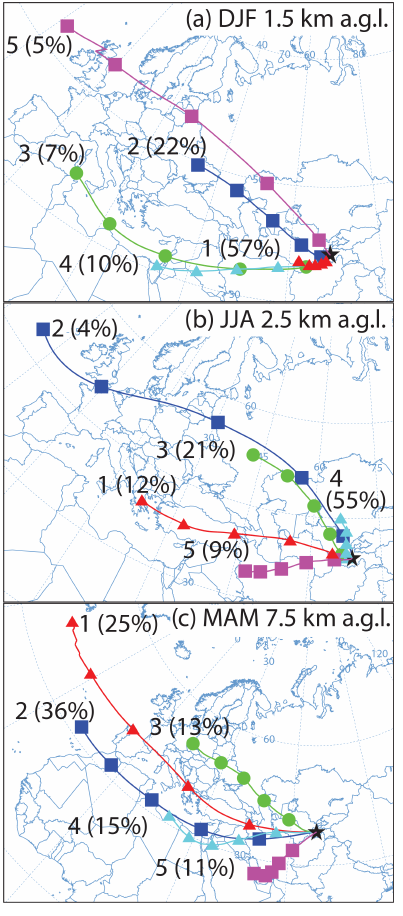
Figure 5. Results of the seasonally resolved HYSPLIT cluster anal- ysis of daily 120h backward trajectories arriving above Dushanbe at (a) 1.5km height a.g.l. (winter season, DJF), (b) 2.5km height (summer season, JJA), and (c) 7.5km height (spring season, MAM). A period of 10 years (2009–2018) of daily HYSPLIT backward trajectories are considered, about 900 trajectories per season. Five clusters are determined for each season. The relative frequency of occurrence of air mass transport belonging to a specific cluster is given in percent at the beginning of the cluster trajectory together with the cluster number. Local and regional aerosol sources con- trol the environmental conditions in the main aerosol layer (below 4–5km height) in winter (a) as well as in summer (b) , while long- range transport of dust from the Middle Eastern deserts and the Sa- hara mainly determine the aerosol conditions in the upper tropo- sphere (above the main aerosol layer) in spring (c) and summer (not shown).